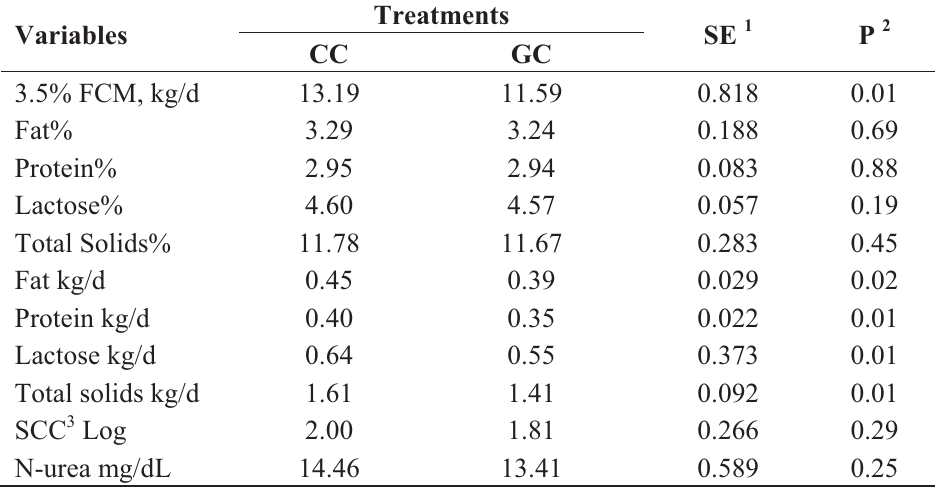
Table 5. Average production of 3.5% fat corrected milk (FCM) and milk composition of cows on pasture supplemented with commercial concentrate (CC) or ground corn